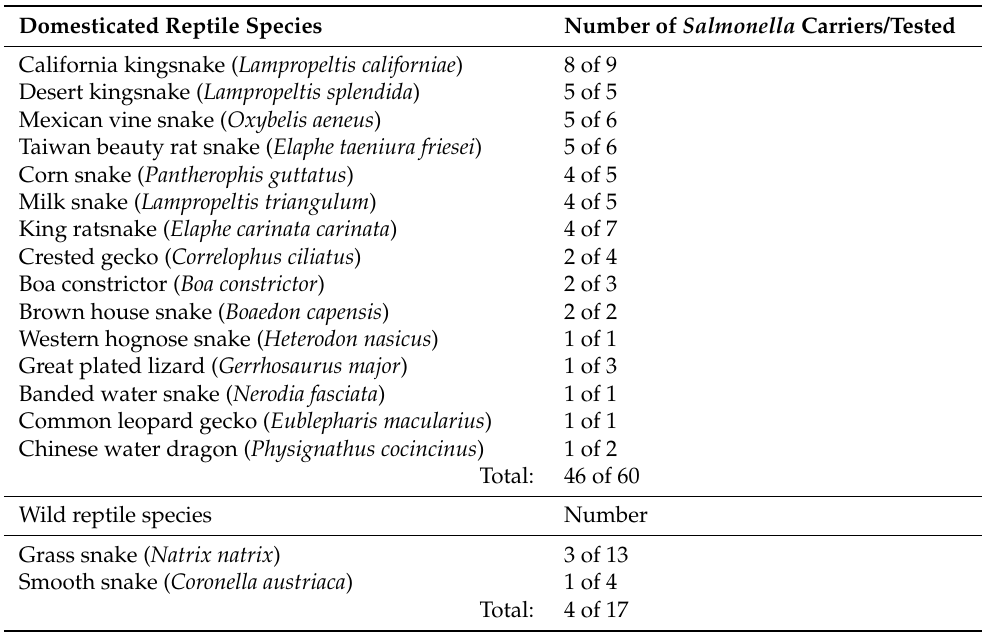
Table 3. Species of reptiles carrying Salmonella